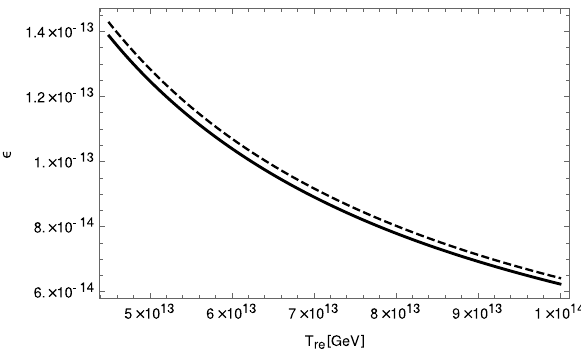
Fig. 16 Same as previous figure, but for M 5 = 10 12